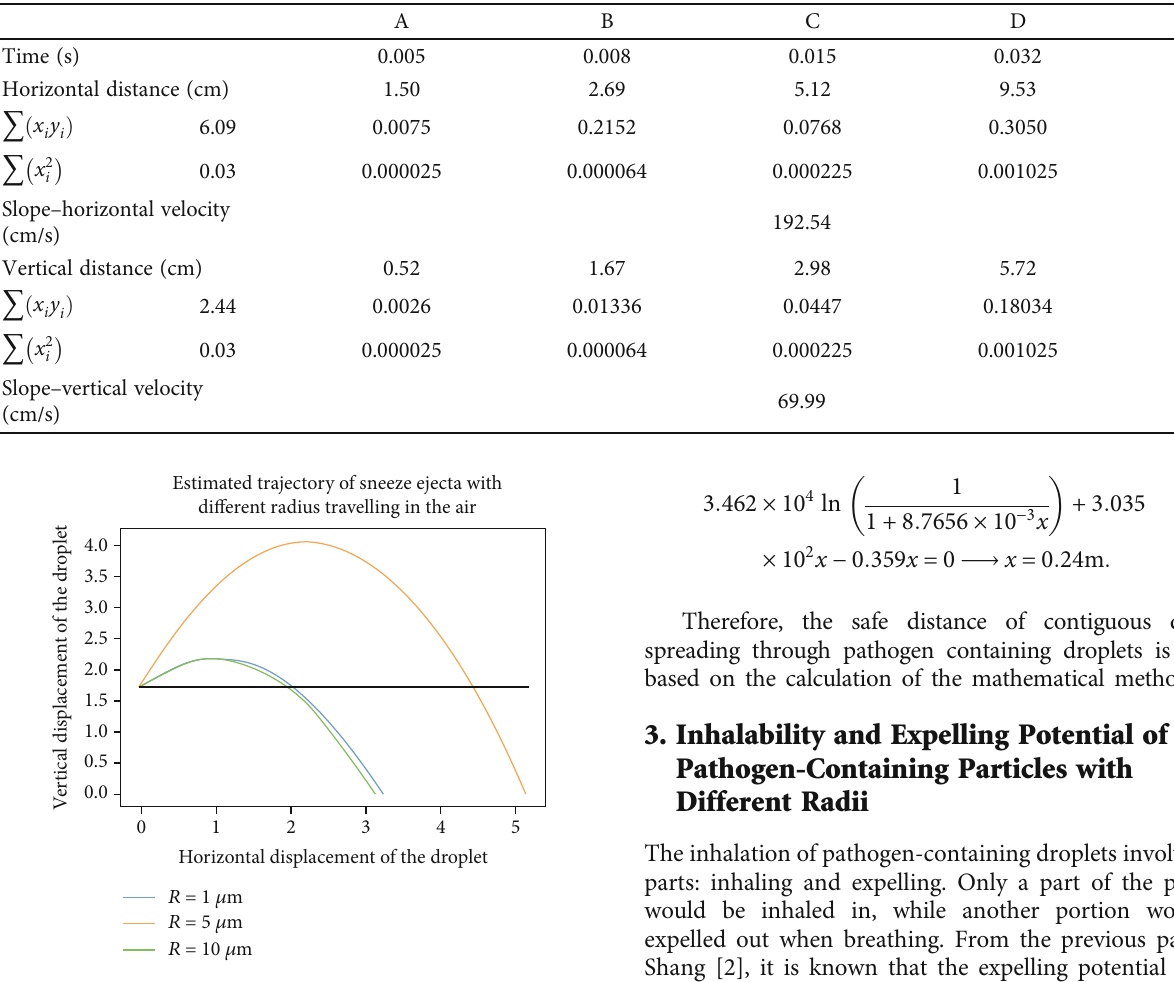
Figure 3: Curve showing the relationship between horizontal and vertical